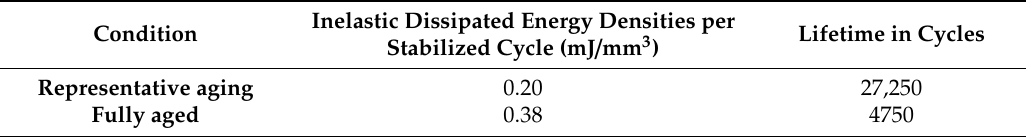
Figure 10. Stress–plastic strain hysteresis loops in critical area for representative aging and asymptotic over-aging conditions, highlighting significative di ff erences between established and proposed model. Table 1. E ff ect of aging conditions used for simulating high-temperature areas on dissipated plastic energy and